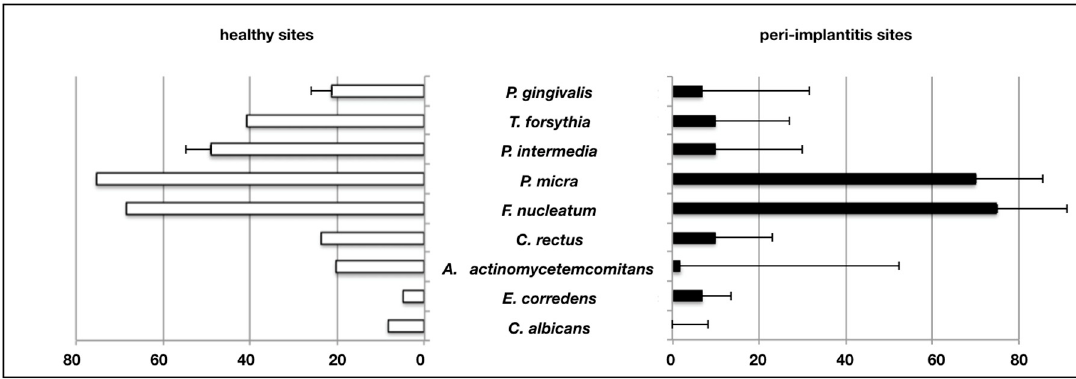
Figure 2. Frequency of positive detection in studies performing culture-based assessment. Weighted percentages of positive assessment in samples from healthy and peri-implantitis sites (bars = means, whiskers = standard deviation).